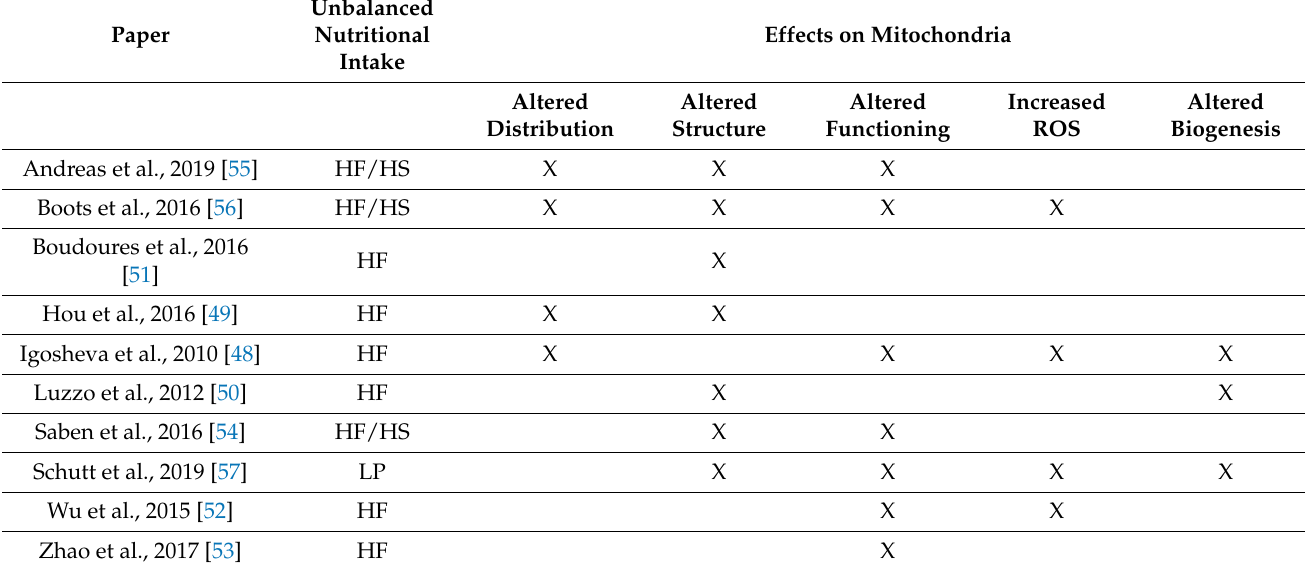
Table 1. Summary of the effects of unbalanced nutritional intake on oocyte mitochondria. All articles were original investigations conducted on the murine model. HF, High Fat; HF/HS, High Fat/High Sugar; LP, Low